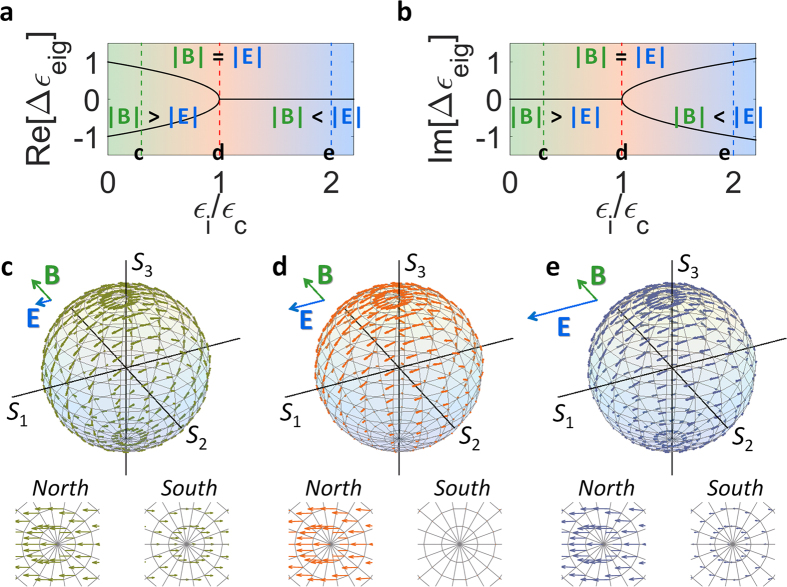
Phases of PT symmetry in terms of the E×B drift.The evolution of the eigenvalues Δεeig is shown in (a) for their real parts (Re[Δεeig]), and in (b) for imaginary parts (Im[Δεeig]). The Lorentz pseudo-force acceleration for each phase of PT symmetry is shown: (c) before the EP with |B| > |E|, (d) at the EP with |B| = |E|, and (e) after the EP with |B| < |E|. The enlarged plots in (c–e) show the distribution of accelerations near the north and south poles.